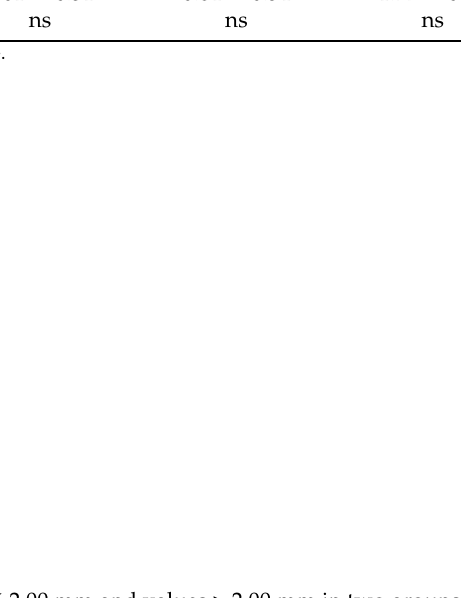
Figure 4. The proportion of the vector error ≤ 2.00 mm and values > 2.00 mm in two